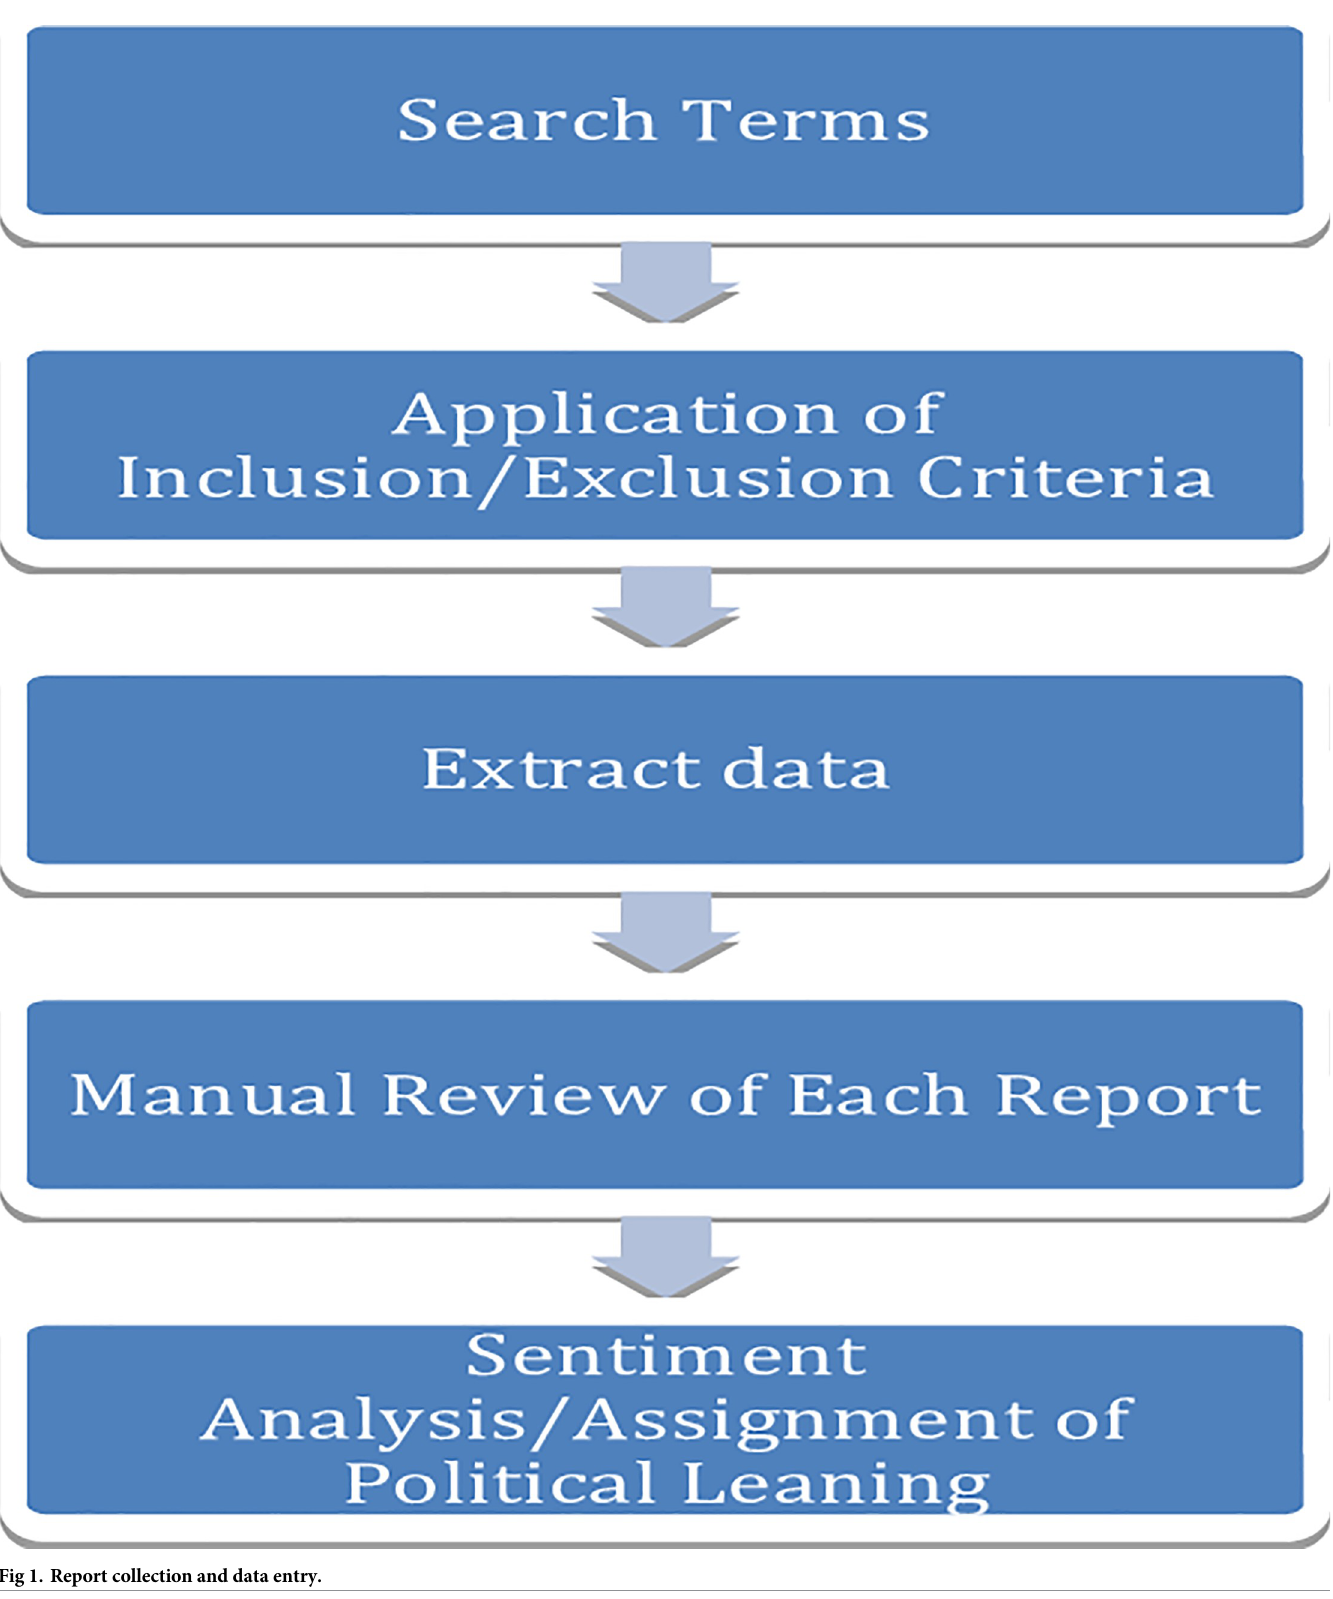
Fig 1. Report collection and data